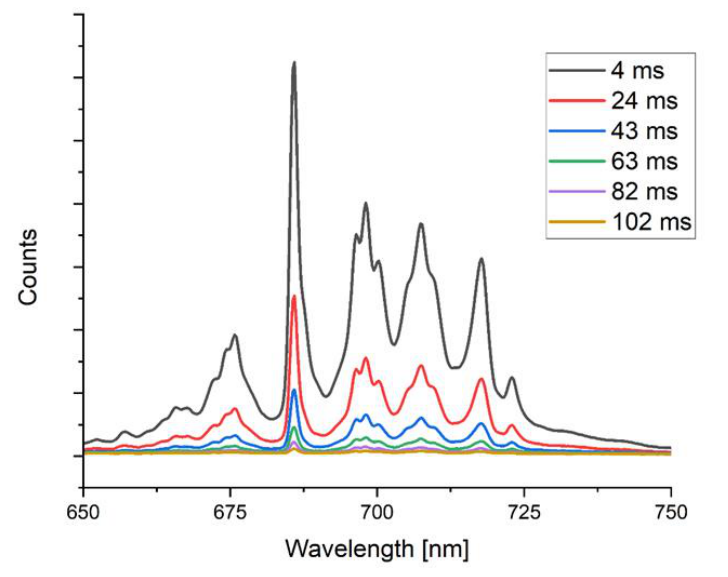
Figure 3. Time-resolved fluorescence decay spectra of natural spinel.